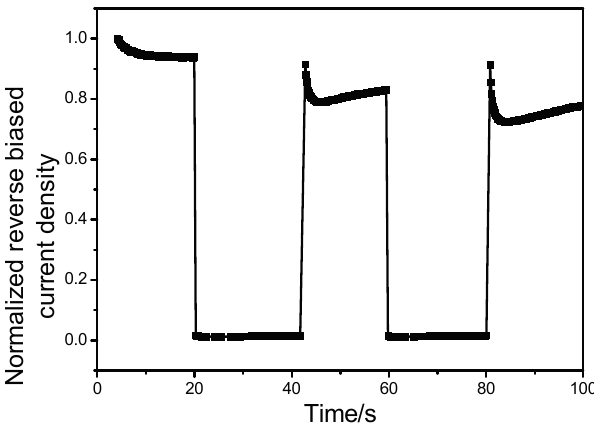
Figure 7. The response time of the ITO/PEDOT:PSS/PFO-DBT:MEH-PPV:PC 71 BM/LiF/Al under pulsed optical illumination with the intensity of 100 mW/cm 2 at − 3 V biasing. The maximum value of current density was ~0.4 mA/cm 2 under 100 mW/cm 2 at − 3 V biasing.